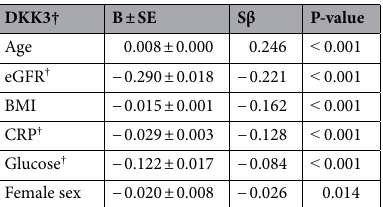
Table 3. Multivariable model including DKK3-associated factors. Sβ standardized beta coefficient. Other abbreviations as in Table 1. R 2 = 0.175. N = 7460. † Log2-transformed.